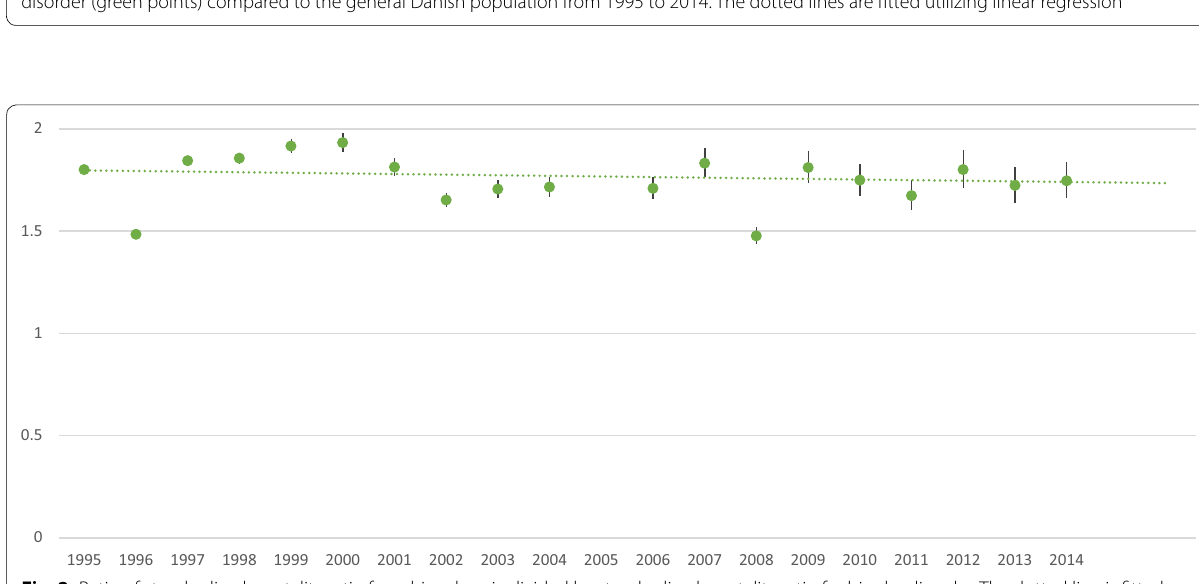
Fig. 2 Ratio of standardized mortality ratio for schizophrenia divided by standardized mortality ratio for bipolar disorder. The dotted line is fitted utilizing linear